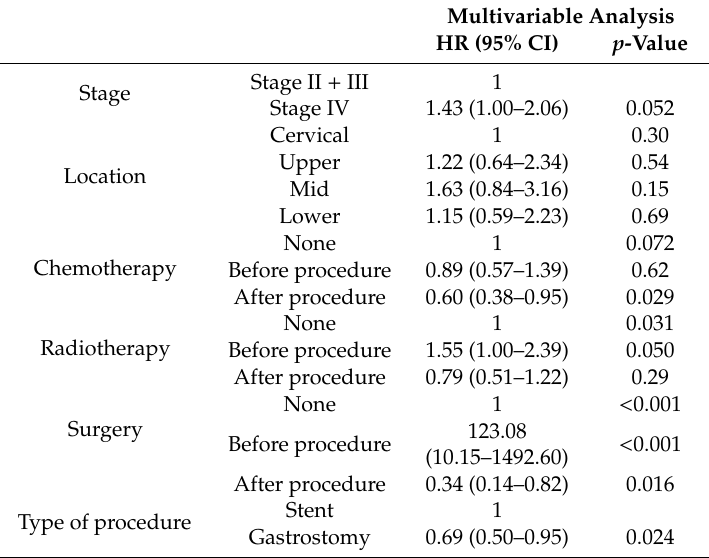
Table 4. Factors associated with overall survival in propensity score matched cohort with malignant esophageal obstruction (94 matched